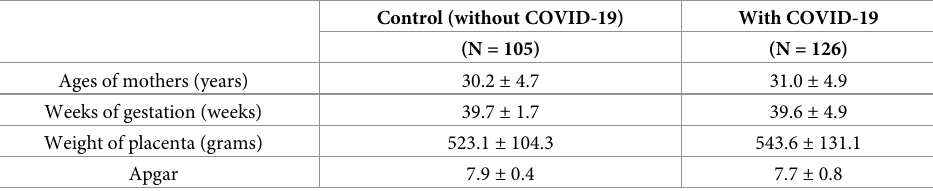
Table 1. Characteristics of samples used in this study (means ±